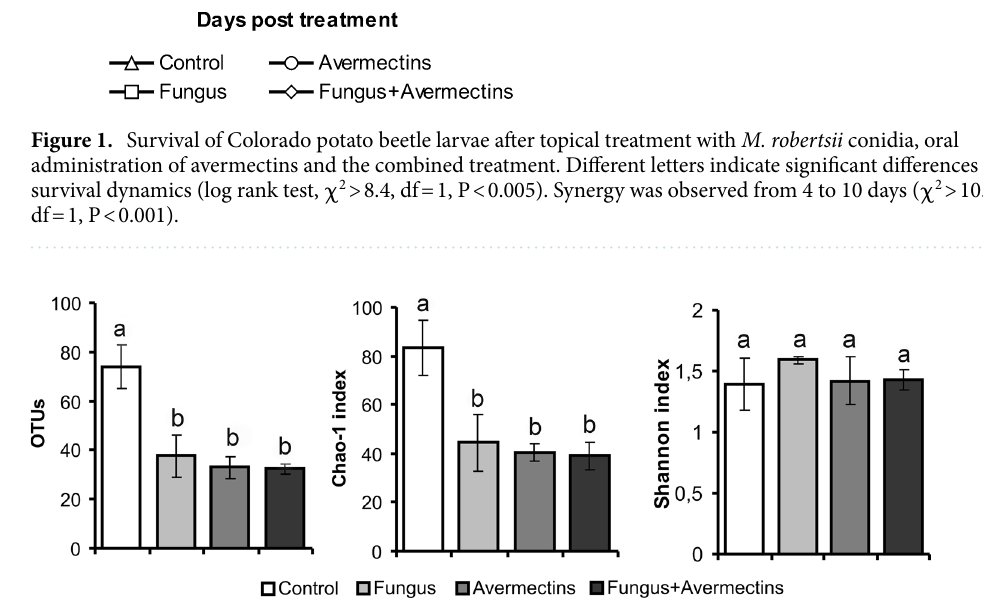
Figure 2. Diversity indexes of midgut bacterial communities of Colorado potato beetle larvae at 48 h after topical treatment with M. robertsii conidia, oral administration of avermectins and the combined treatment. Different letters indicate significant differences between treatments (Tukey’s test, P <